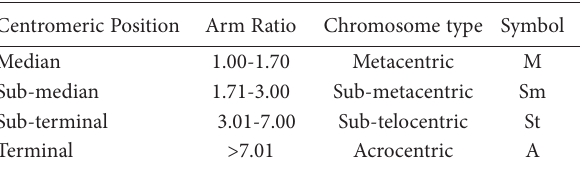
Table 1. Nomenclature for designating chromosome type Levan et al.